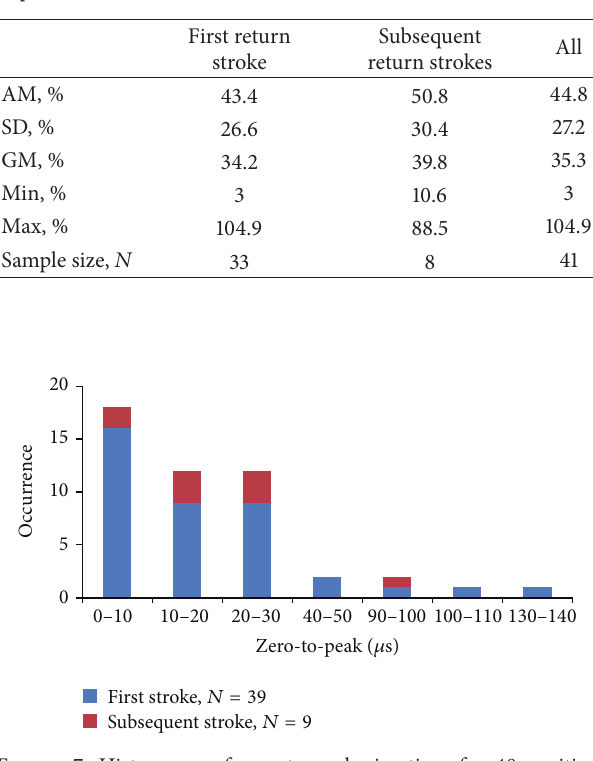
Figure 7: Histograms of zero-to-peak rise time for 48 positive return strokes.